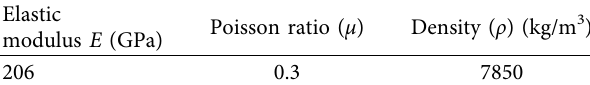
Table 3: Piping system model material